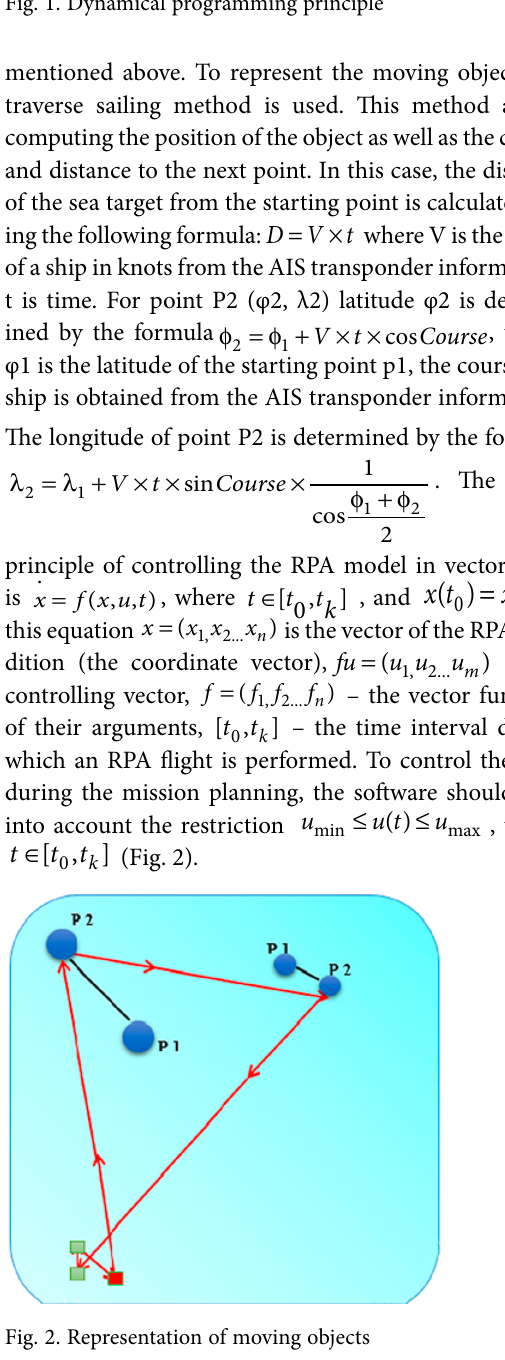
Fig. 1. Dynamical programming